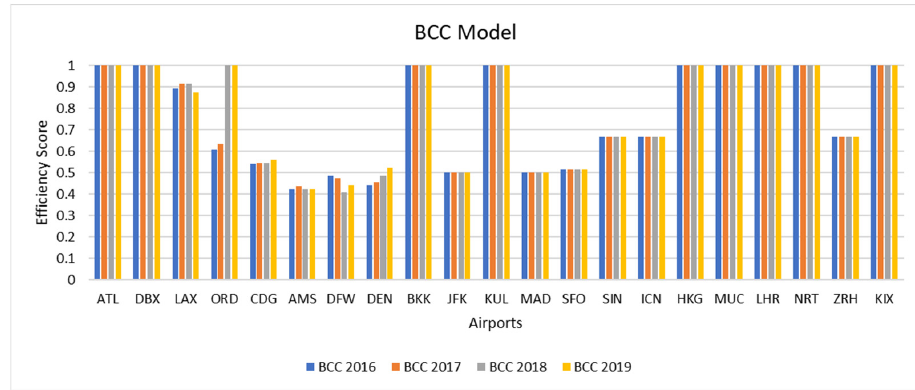
Figure 4. Efficiency score of the BCC model.